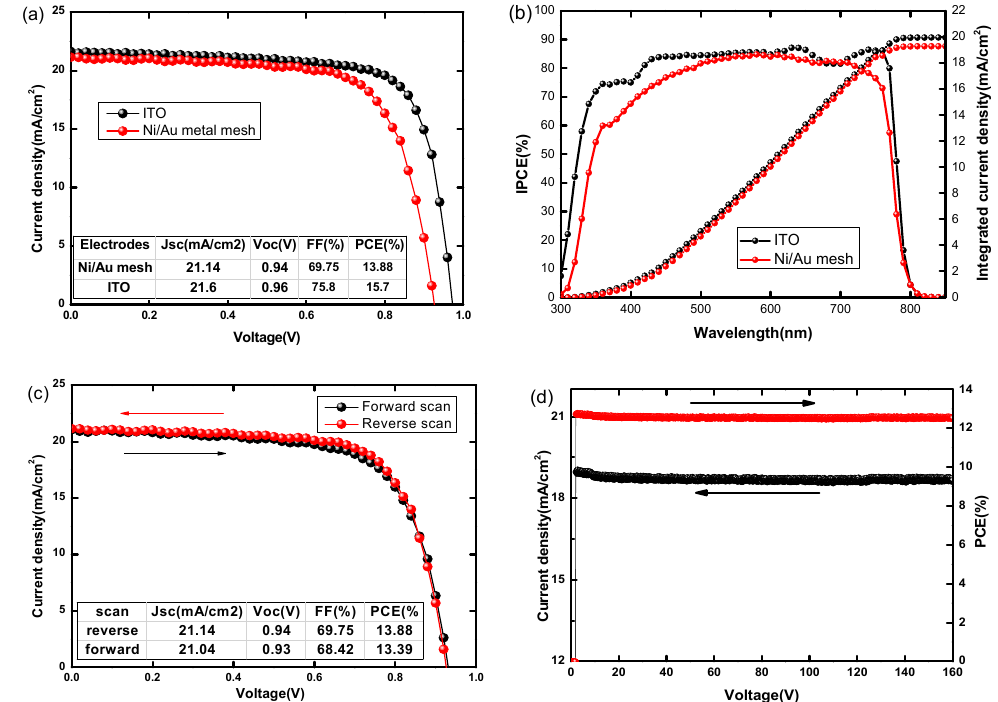
Figure 3. ( a ) J ‐ V curves and ( b ) incident photo ‐ to ‐ current conversion efficiency (IPCE) spectra of PSCs based on Ni / Au mesh and PSCs based ITO measured under 100 mW / cm 2 AM 1.5 G illumination; ( c ) J ‐ V curves in forward and reverse scans and ( d ) steady output current density and PCE of PSCs based on Ni/Au mesh and the maximum power point (Vmax = 0.67 V).